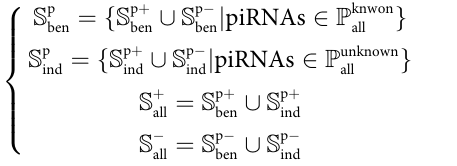
Table 1. The detailed statistical information of S a Datasets